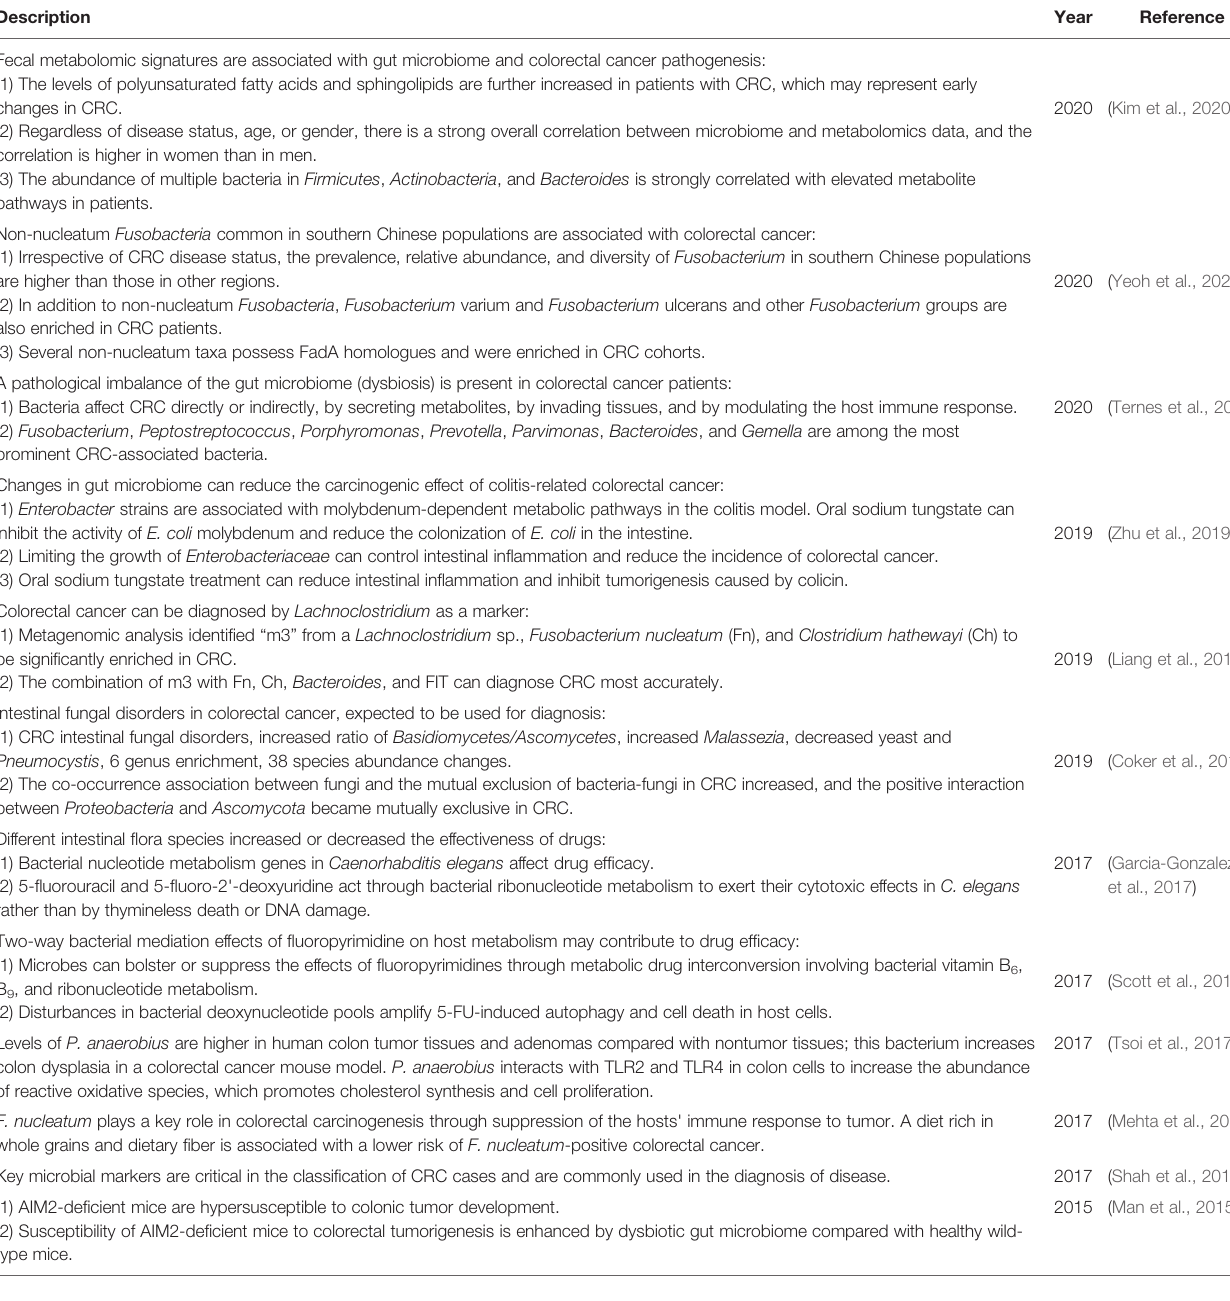
TABLE 2 | Recent studies on the close relationship between colorectal cancer (CRC) and the gut